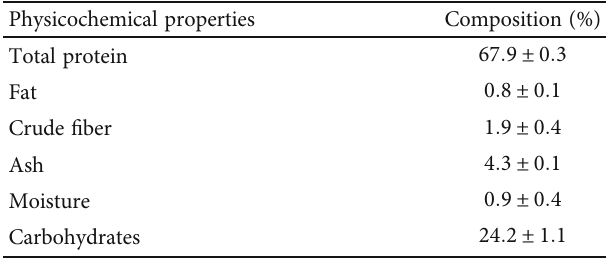
Table 1: Chemical composition of